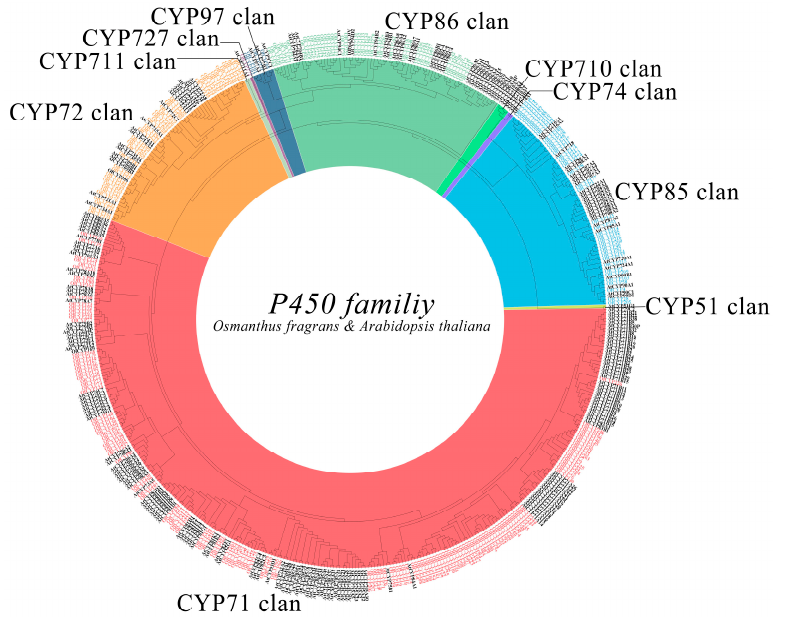
Figure 1. Phylogenetic analysis of 276 OfCYP and 264 Arabidopsis (black labels) AtCYP proteins. The ClustalW program was used to perform alignment, and then all proteins were imported into MEGA 7.0 to build the phylogenetic tree by the neighbor-joining approach with 1000 bootstrap iterations.